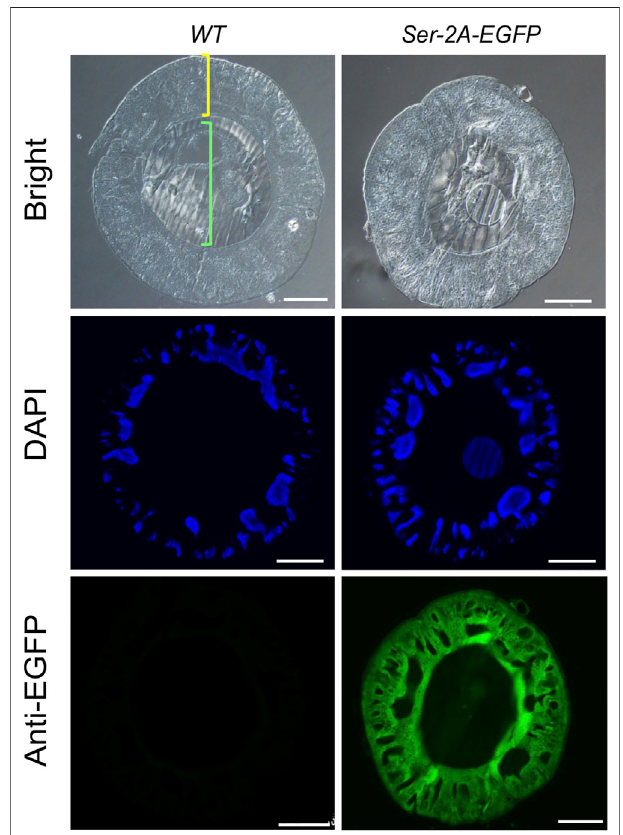
FIGURE 4 | Immunohistochemistry of EGFP in the MSG of Ser – 2A – EGFP animals. EGFP protein distributes in the sericin layer of the MSGs as indicated by the anti-EGFP primary antibody. The yellow bracket indicates the cellular layer and green bracket indicates the lumen of MSGs. MSGs were dissected from the WT or Ser – 2A – EGFP animals at the third day of the fi fth instar larvae (L5D3). Hoechst was used to stain the nucleus. Scale bars stand for 100 μ